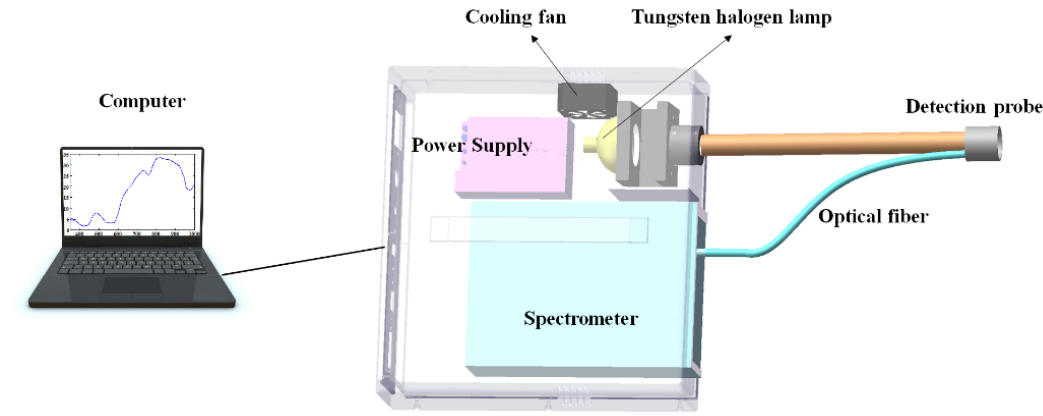
Figure 1. Schematic diagram of Vis/NIR spectroscopy system. This figure shows the experimental equipment for the quality detection of sheep meat cuts using Vis/NIR spectroscopy.